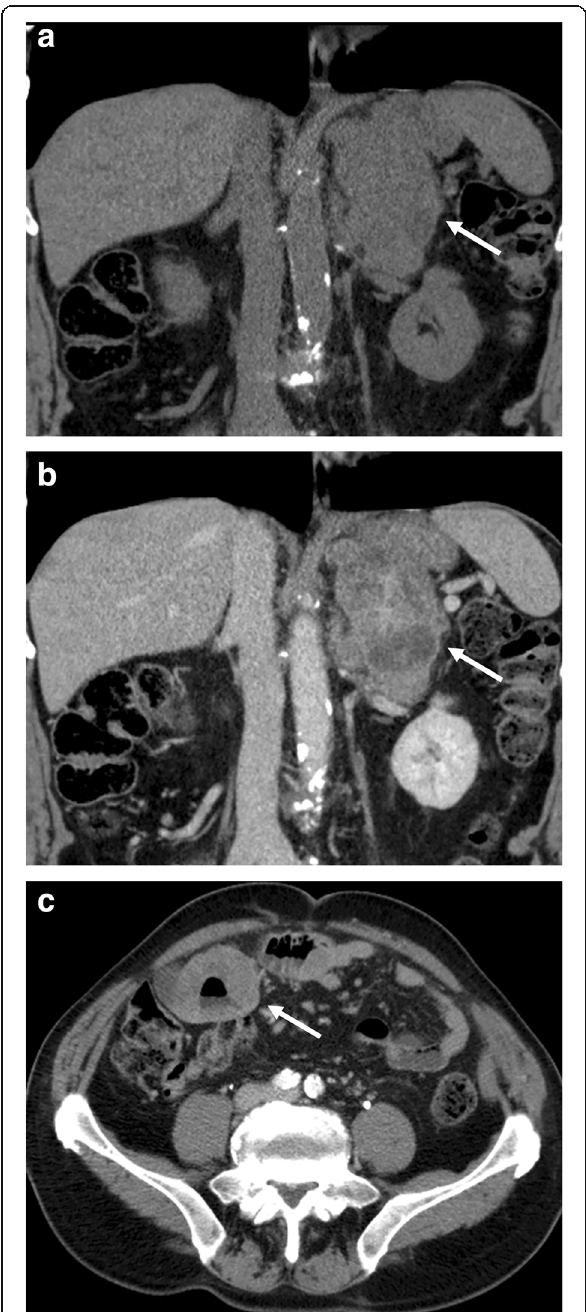
Fig. 9 Left adrenal lymphomatous lesion in a 70-year-old man with non-Hodgkin lymphoma. Coronal reformatted CT images before ( a ) and after contrast injection in portal phase ( b ) show a large left adrenal mass (arrow) with inhomogeneous enhancement. Axial CT image of the lower abdomen in portal phase ( c ; arrow) shows the gastrointestinal involvement by lymphoma as aneurysmal dilatation of some loops of the small